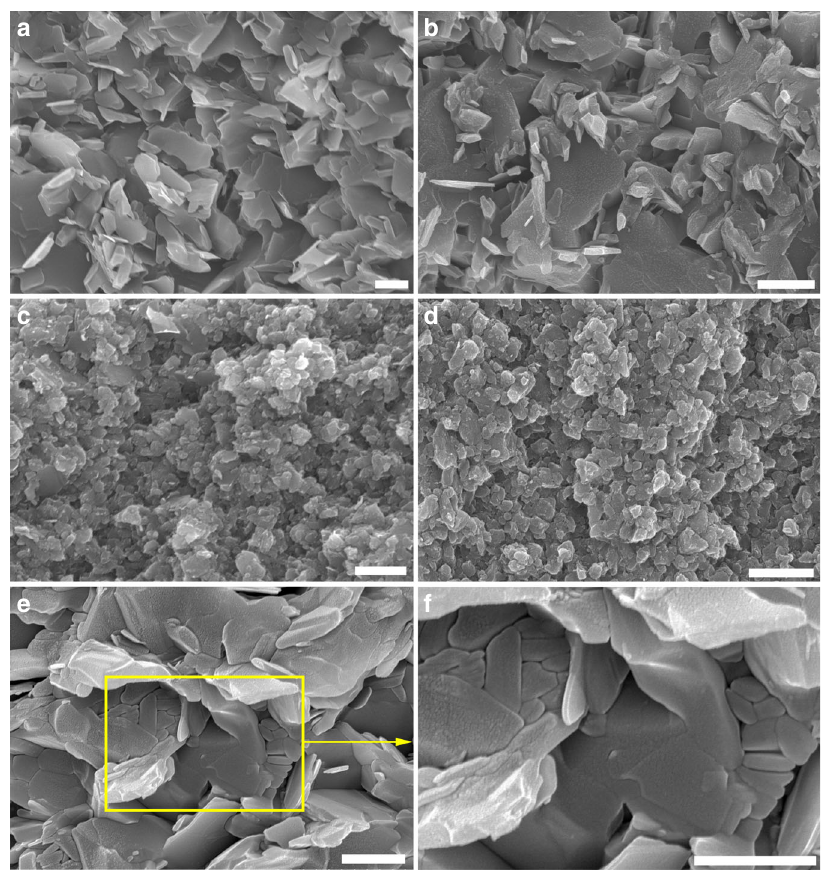
Fig. 8 FESEM micrographs of the as-prepared samples. The fracture surfaces of pure hBN ceramics ( a ), HSHBN-30 ( b ), HSHBN-80 ( c ) and HSHBN-100 ( d ); squashed BN onions in HSHBN-30 ( e , f ). All scale bars represent 1 µ